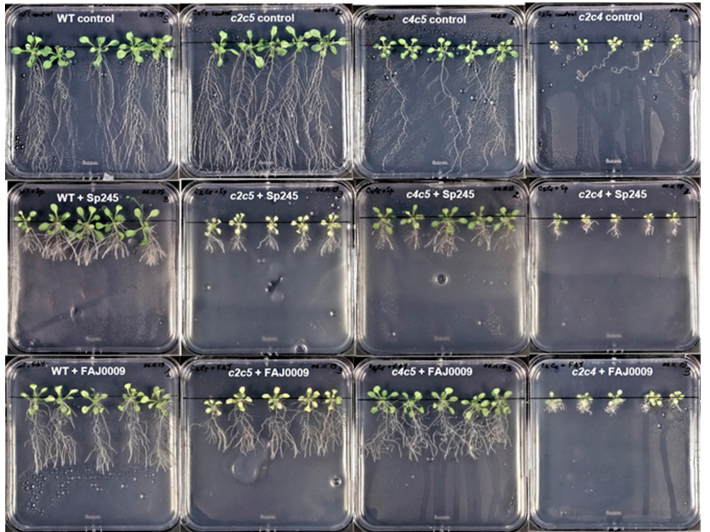
Figure 9. Visual phenotype of Arabidopsis WT and double mutants treated with A. brasilense . Seedlings of Arabidopsis WT and double mutants c2c5 , c45 , c2c4 were cultivated without bacteria (upper row) and with A. brasilense Sp245 (middle row) and with A. brasilense FAJ0009 (lower row) for two weeks.